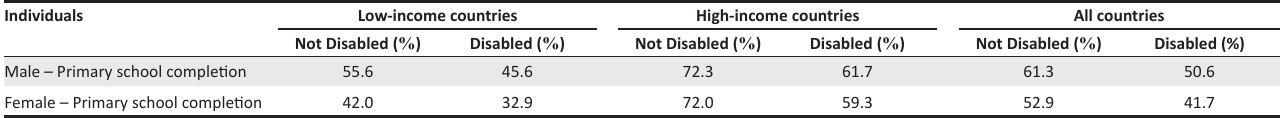
TABLE 1: Education outcomes for disabled and not-disabled respondents in 2002–2004.